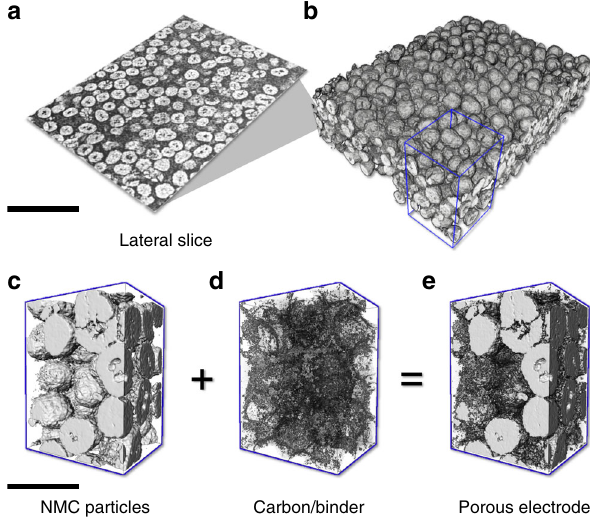
Fig. 1 3D microstructure of the composite battery cathode. a , b An overview of a relatively large area on the electrode, which covers hundreds of NMC particles, with the central lateral virtual slice displayed in ( a ). c – e A smaller region of interest (the region highlighted by the blue box in ( b )) with the active NMC particles ( c ) and the inactive carbon/binder domains ( d ) rendered separately and jointly ( e ). The scale bars in ( a ) and ( c ) are 60 and 20 μ m,